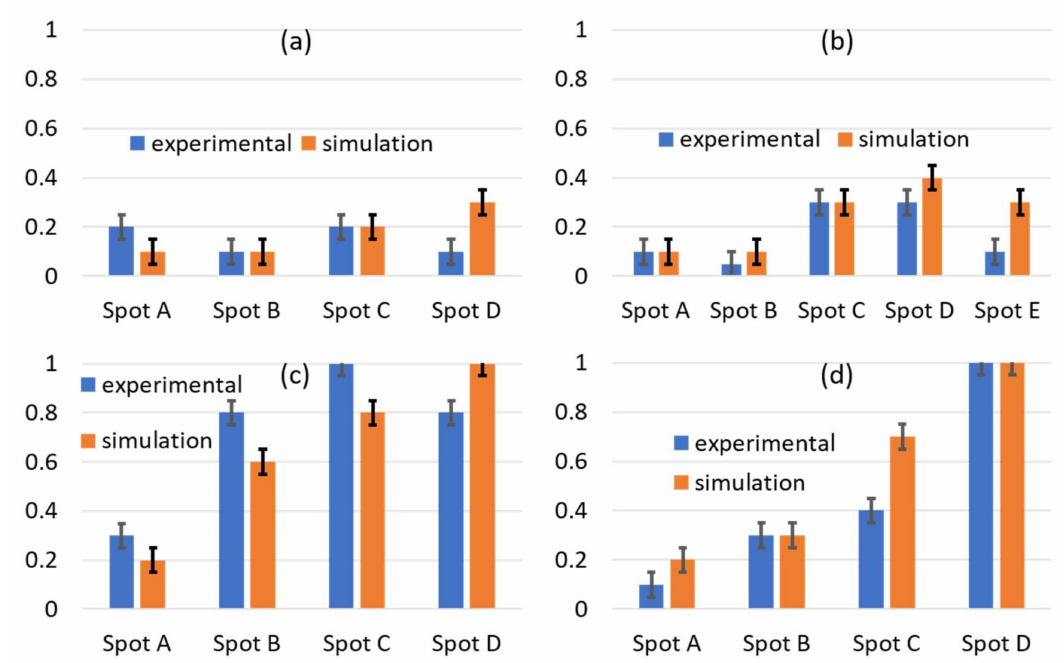
Figure 9. Spectral-angular data conversion for TE of each prominent “spot” to 1D column graph. The labels A, B, C, D, and E refer to the spots from left to right in Figure 7 in each intensity map at different incident angles: 30 ◦ ( a ), 40 ◦ ( b ), 50 ◦ ( c ), and 60 ◦ ( d ). Error bars reflect a 10% uncertainty. All intensities are on a relative zero to one scaling system.